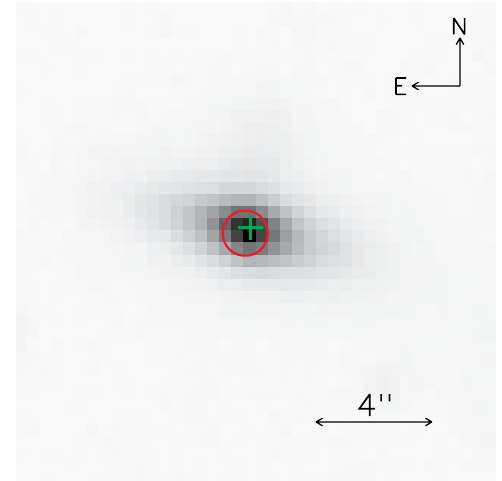
Figure 3. The optical image of the galaxy in the V band [19]. The pixel size is 0 . (cid:5)(cid:5) 414. The green plus marks the central position of the galaxy obtained from the fits to its V- and I- band profiles using a S´ersic model, and it is at RA = 18:47:25.14, Dec = − 63:17:24.77 (J2000). The red circle is centered at the X-ray position (RA = 18:47:25.16, Dec = − 63:17:24.96 (J2000)), with the radius corresponding to the 3- σ error of 0 . (cid:5)(cid:5)